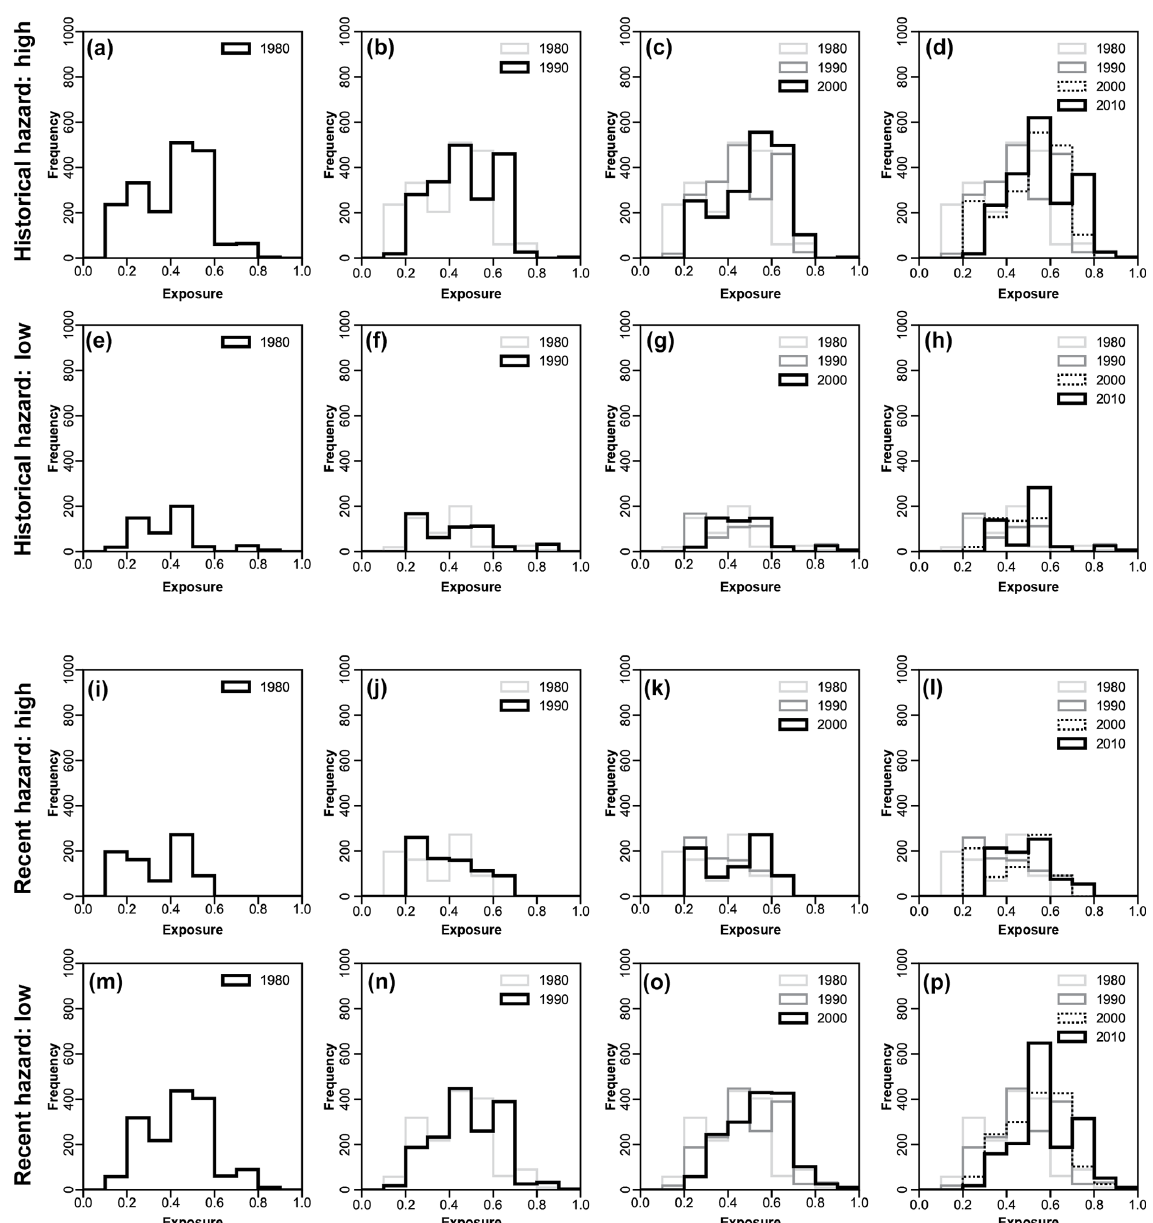
Figure 7. Transect-level distribution of exposure per coastal kilometre, by decade, under (a–h) high and low historical and (i–p) high and low recent shoreline-change hazard. “High” hazard here is a value greater than 0.272 (the normalized value for a shoreline-change rate of zero); “low” hazard is a value greater than 0.272. High hazard therefore indicates erosion, and low hazard indicates accretion. Summary statistics for these distributions are provided in Table